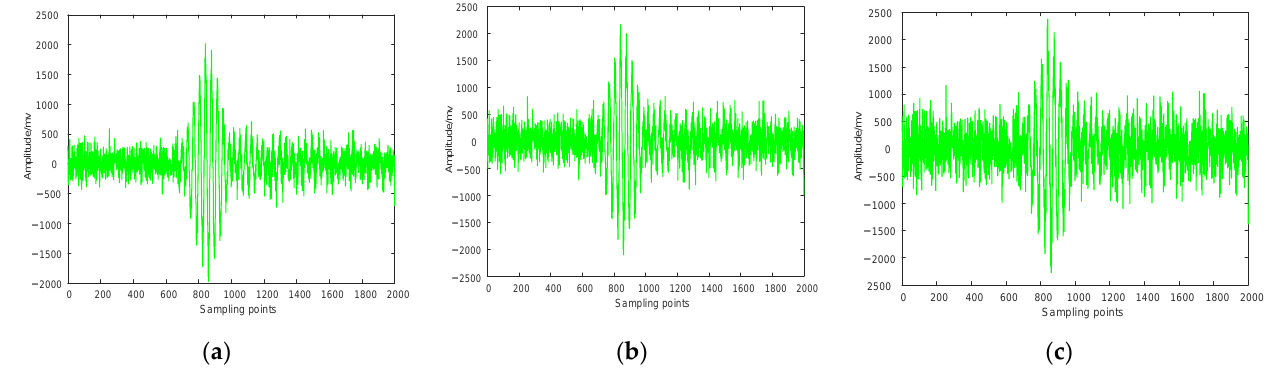
Figure 18. Damage scattering signals with different signal-to-noise ratios at 2 – 8 channels: ( a ) SNR = 6; ( b ) SNR = 3; ( c ) SNR = 0.1.